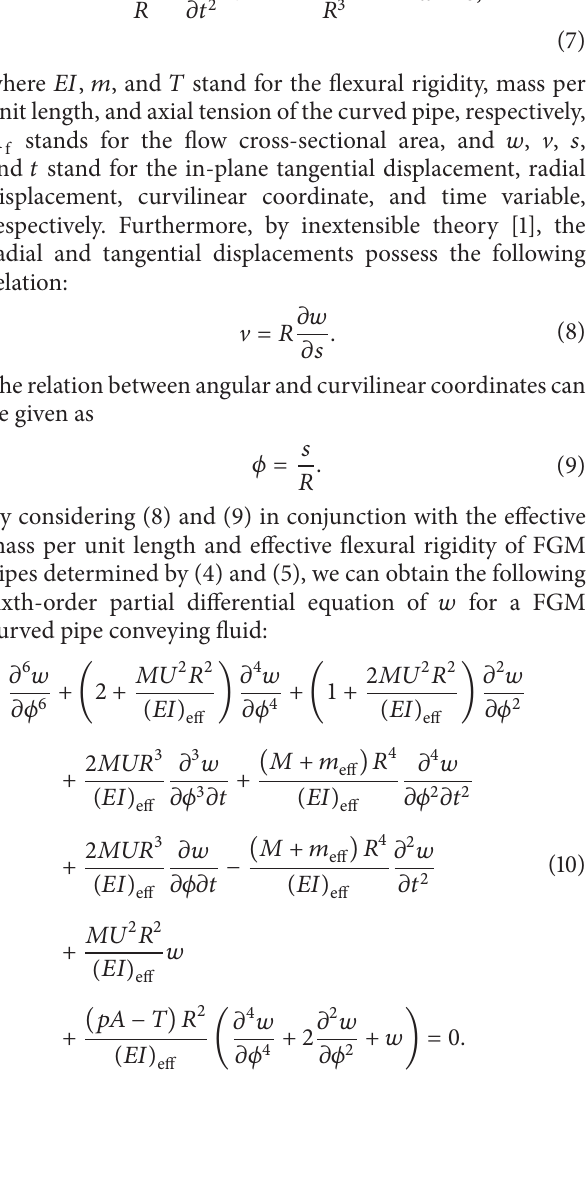
where Γ in and Γ out denote the properties of the inner and outer materials, respectively, and 𝑉 in and 𝑉 out are the corresponding volume fractions. For the FGM curved pipe considered, 𝑉 in can be expressed according to the power law